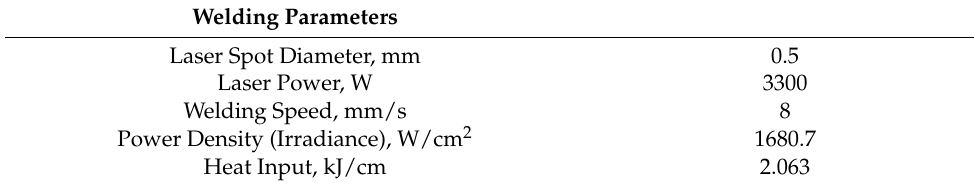
Table 2. Autogenous laser welding parameters.